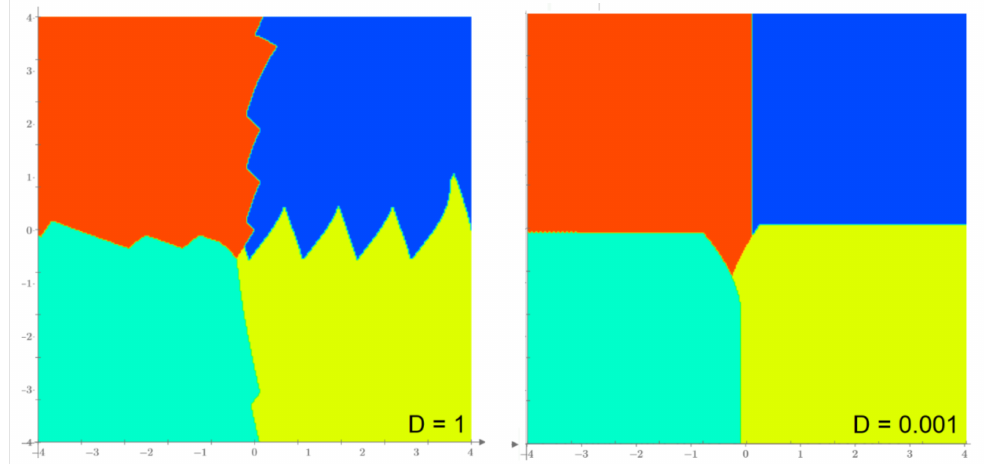
Figure 24. “Portrait” of the numerical search for the minima of the function for different values of the